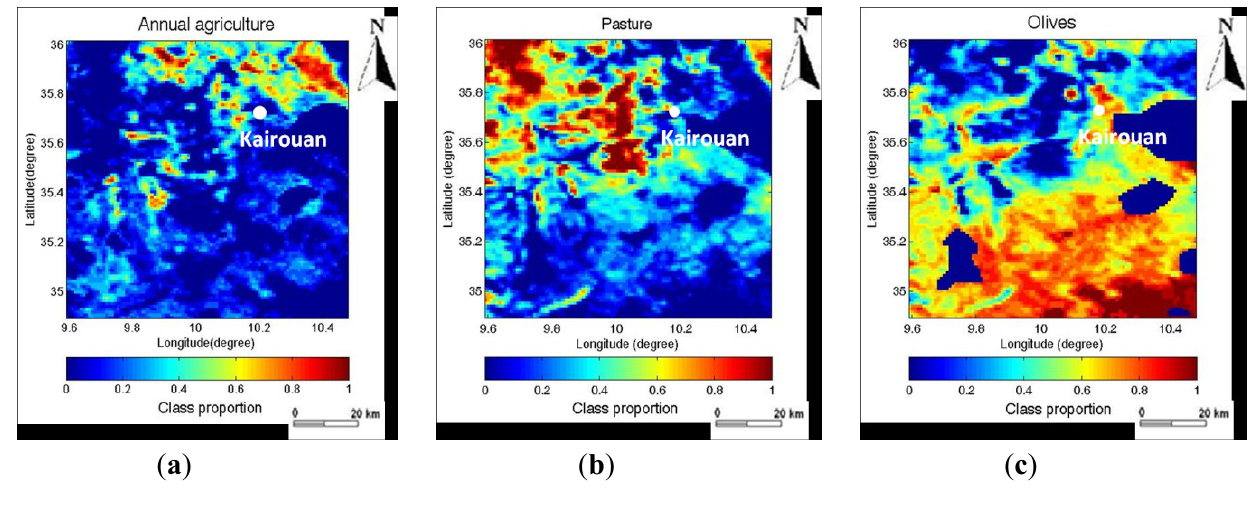
Figure 2. Land use map for the 2008–2009 agricultural season at 1 km spatial resolution, showing (on a scale ranging from 0–1) the proportion of coverage represented by each of three different classes of vegetation present in this area: ( a ) annual agriculture; ( b ) pastures; ( c ) olive